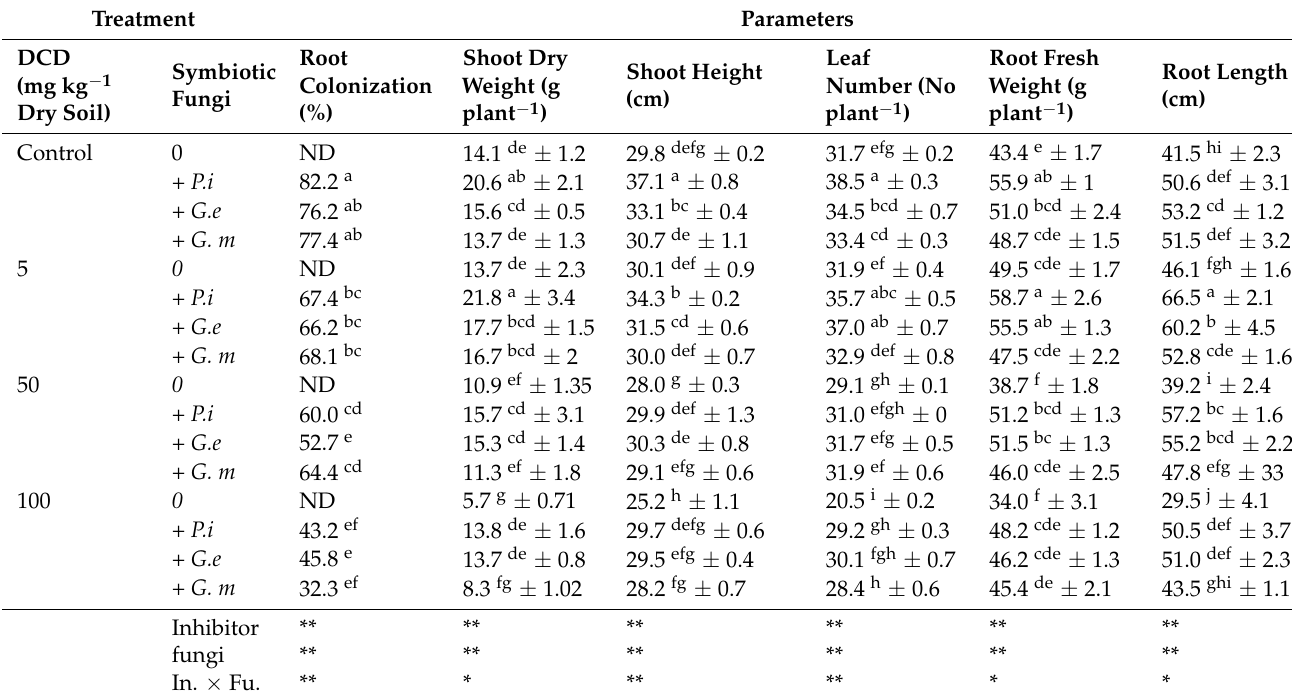
Table 1. Effect of distinct DCD concentrations on root colonization by Piriformospora indica ( P.i ), Glomus etunicatum ( G.e ), and Glomus mosseae ( G.m ), shoot dry weight, shoot height, leaf number, root fresh weight, and root length of lettuce plants.